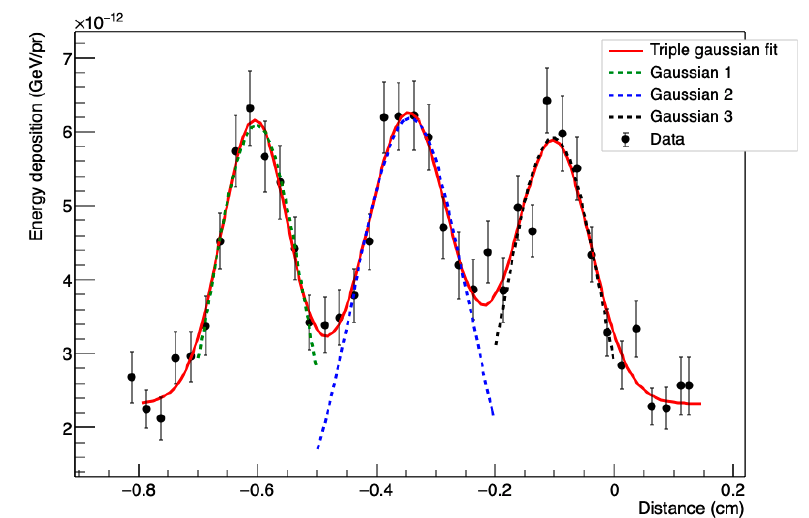
Figure 17. One-dimensional projection of the 1.3 mm holes with 2.5 mm pitch. The LSF of the selected area gives a distribution with an average hole diameter of 1.47 mm. Table 2. Calculated FWHM of the 1D profiles for the different regions of interest depicted in Figure 16.